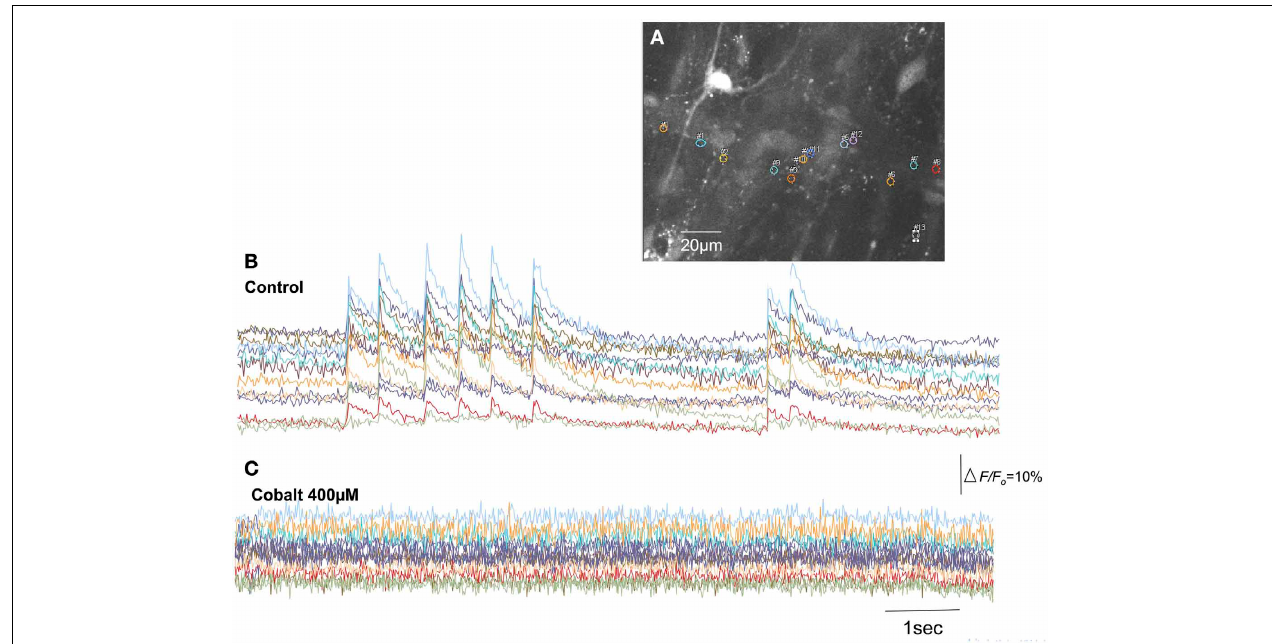
FIGURE 8 | Blockade of extracellular calcium influx through voltage-sensitive Ca 2 + channels with cobalt abolishes calcium transients in spinal afferent nerve terminals. (A) Shows the camera image of a single myenteric ganglion in which calcium transients were detected in single varicosities along a single spinal axon. (B) Shows